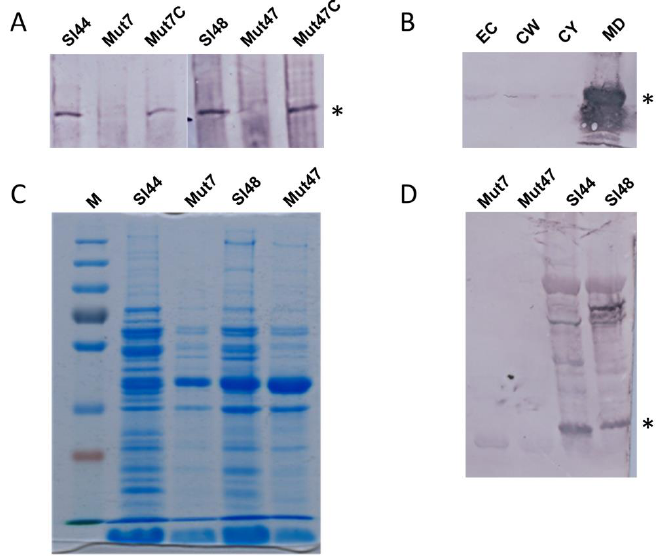
Figure 3. Western blot and SDS page experiments of S. lugdunensis wild type, ∆ srtA mutant and complemented mutant strains showing the presence and localization of SrtA and consequences of a srtA deletion for the surface proteome pattern. ( A ) Western blots showing the absence of SrtA in the mutant strains but specific signals in wild types and complemented mutants. Whole cell extracts of wild type, mutant and complemented mutant strains were separated via SDS page and blotted. The Western blots were probed with specific polyclonal antibodies rose in rabbits against recombinant SrtA (anti-SrtA). Asterisk mark the specific SrtA band. ( B ) Localization of SrtA within S. lugdunensis cells. For this purpose, S. lugdunensis were grown in BHI broth medium. Cells were fractionated into the extracellular fraction (EC), cell wall fraction (CW), cytosol fraction (CY), and membrane digest fraction (MD). Proteins were separated by SDS page. After blotting, SrtA was detected in the different fractions with anti-SrtA antibodies. Asterisk mark the specific SrtA band. ( C ) Analyses of cell surface proteins of the wild-type strains and the mutant strains. The cell surface proteins were extracted in 0.1 M hydroxylamine hydrochloride. The protein extracts were separated on SDS-Page and stained with Coomassie Blue. ( D ) Cell surface protein fractions of wild type and mutant strains were separated via SDS page. After blotting, the Western blots were probed with a mixture of antibodies raised in rabbits against formaldehyde fixed whole cells of S. lugdunensis . Asterisk mark the specific SrtA